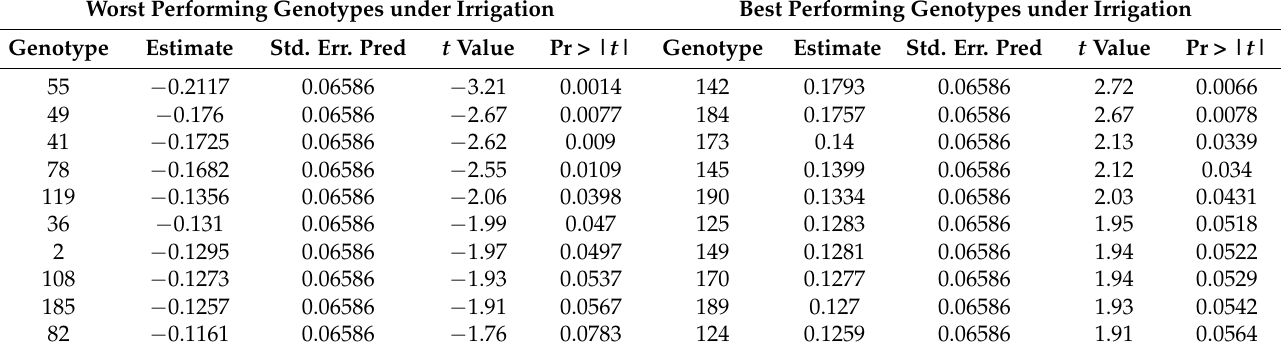
Table 7. The performance of genotypes under irrigation.